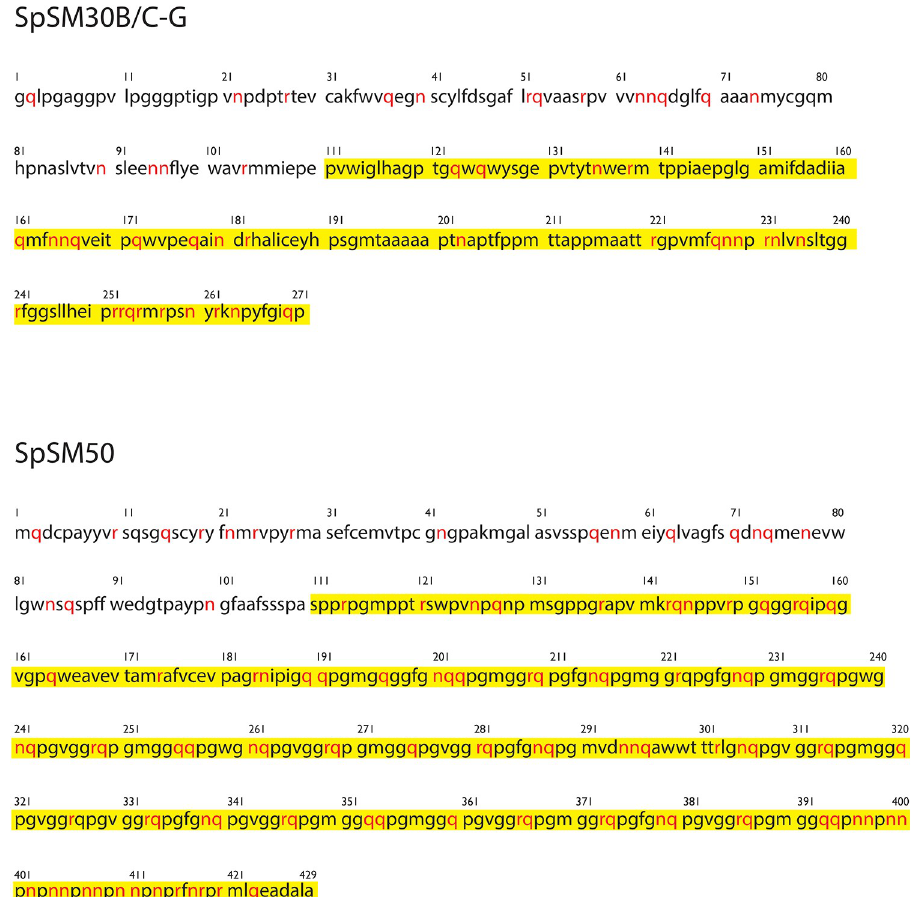
Fig 3. Primary sequences of SpSM30B/C-G and SpSM50. Arg, Gln, and Asn residues are presented in red. MAQPG domains are highlighted in yellow. Note high concentration of Arg, Asn, Gln within disordered MAQPG